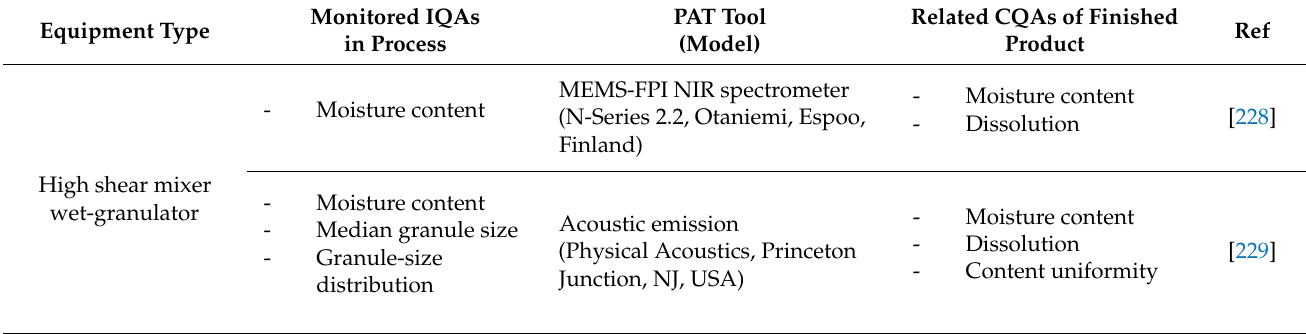
Figure 2. Overview of the process monitoring of roll compaction and tableting: the implementation of near-infrared chemical imaging (NIR-CI) to obtain information related to the physical or chemical properties of intermediate products or finished products [175]. Reproduced with permission from Milad Khorasani, European Journal of Pharmaceutics and Biopharmaceutics; published by Elsevier, 2015. Table 3. Summary of the PAT-based modeling method applied in the granulation